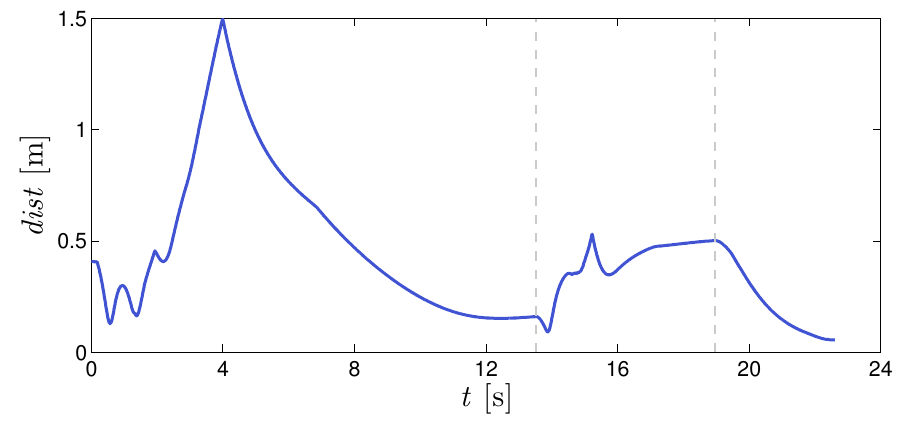
Figure 10. The distance of the robot from the obstacles.